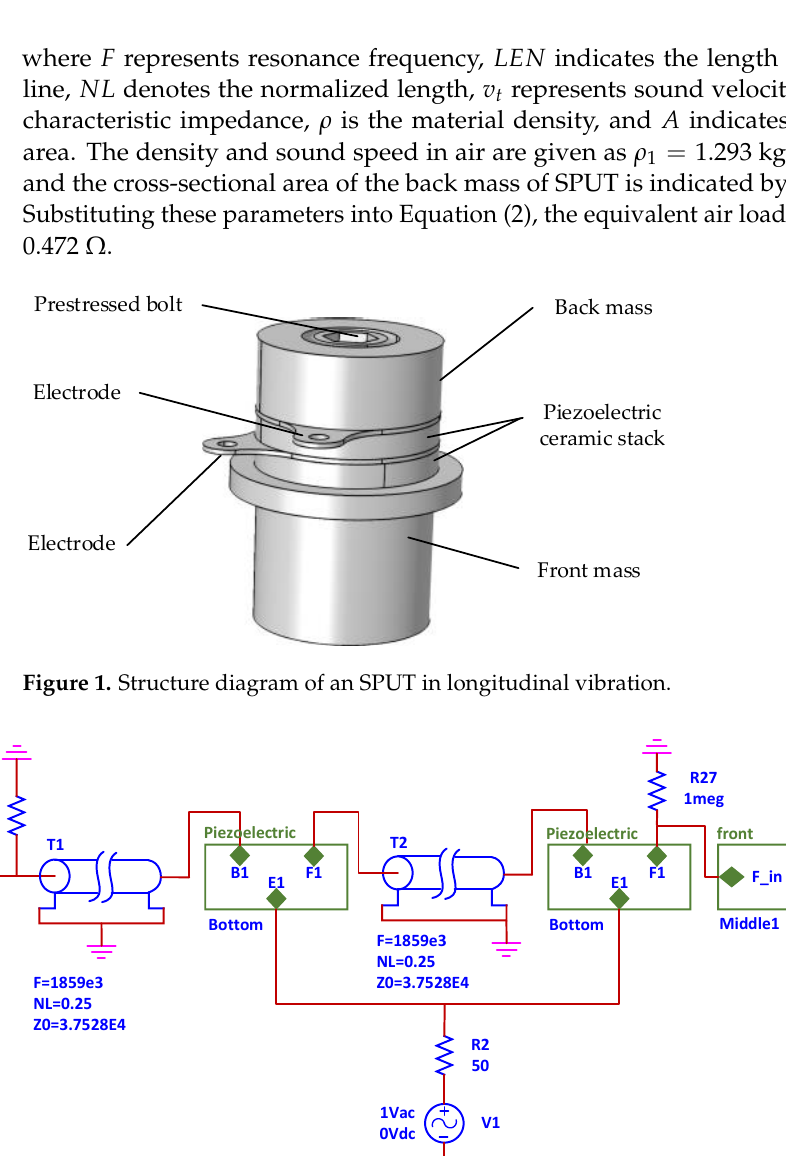
Figure 2. PSpice model of an SPUT in longitudinal vibration.